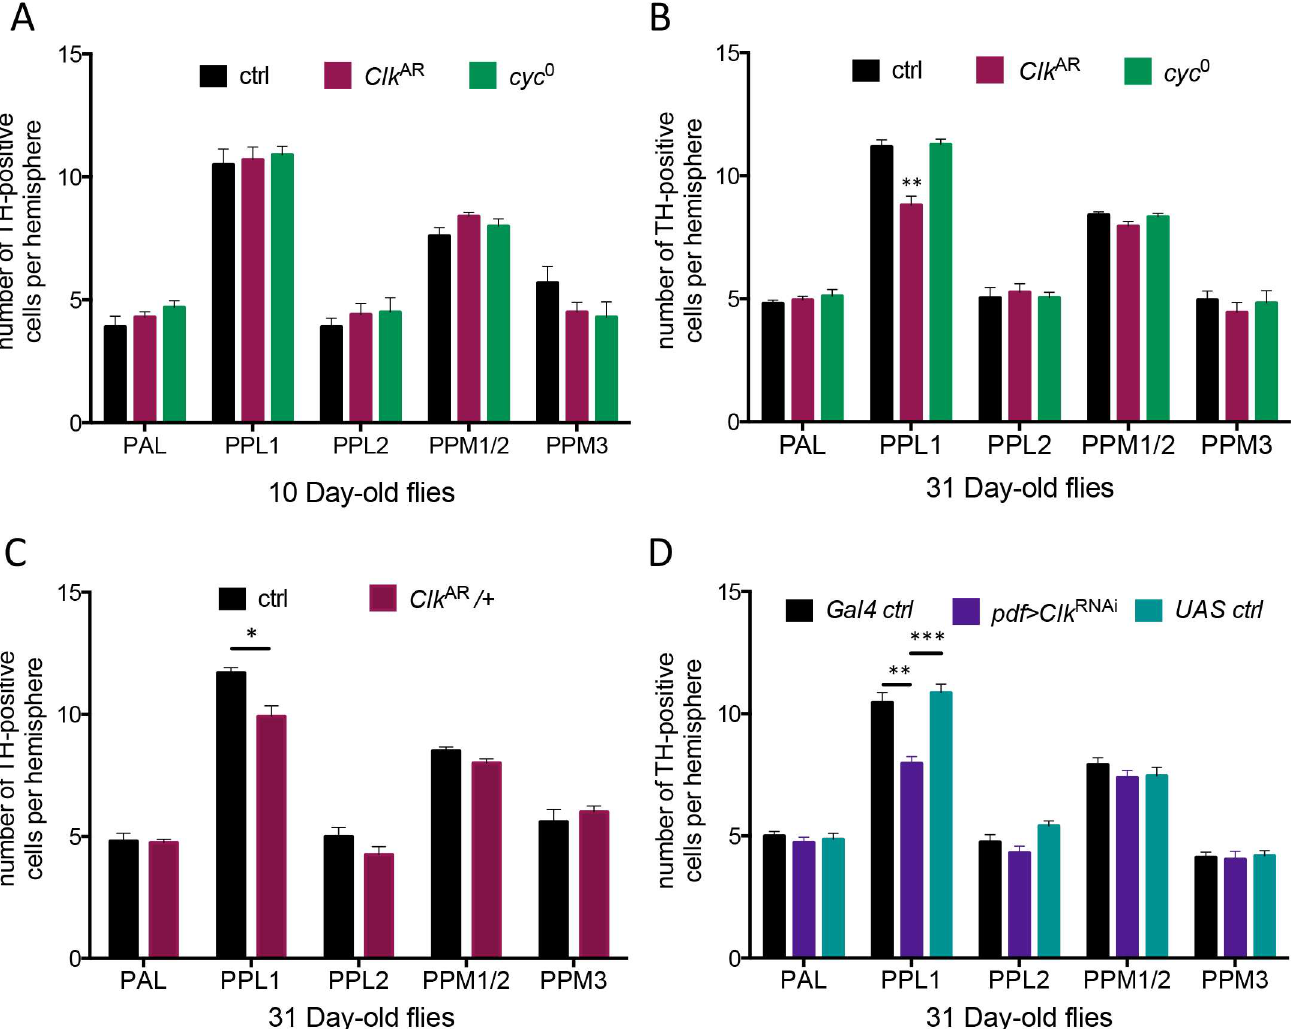
Fig 5. Specific loss of dopaminergic PPL1 neurons in Clk -deficient flies. TH-IR cells were countedin confocalstacks of brains dissected from flies of the indicatedages and genotypes.In all panels,histograms displaythe mean ± SEM of TH-IR cell numbersin the PAL, PPL1, PPL2, PPM1/2 and PPM 3 clusters, from 2 independent experiments with 8–10 brains per genotypein each experiment. (A) At 10 days of age, the number of TH-IR neuronsin the different dopaminergic neuronalclusters of Canton-S(ctrl), Clk AR and cyc 0 flies was similar. (B) Clk AR mutants exhibiteda selective loss of TH-IR cells in the PPL1 neuronalcluster at 31 days post-eclosion when comparedto either controls or cyc 0 . (C) Loss of TH-IR cells in the PPL1 neuronalcluster was also observedat 31 days post-eclosion in Clk AR /+ heterozygote flies. (D) Reducing Clk levels in the PDF neuronsspecifically decreased the numberof PPL1 TH-IR cells. PAL, protocerebral anterior lateral; PPM1-3, protocerebral posterior median 1–3; PPL1-2, protocerebral posterior lateral 1–2.